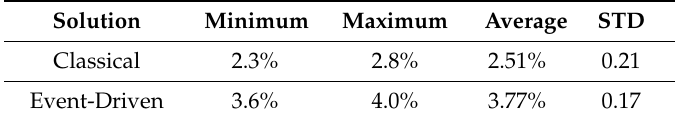
Table 3. The summary of MPSOCEs .